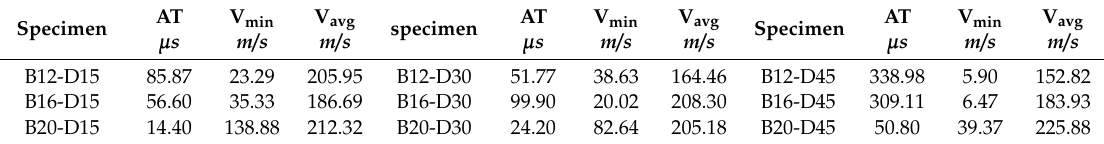
Table 4. Crucial data of crack propagation.